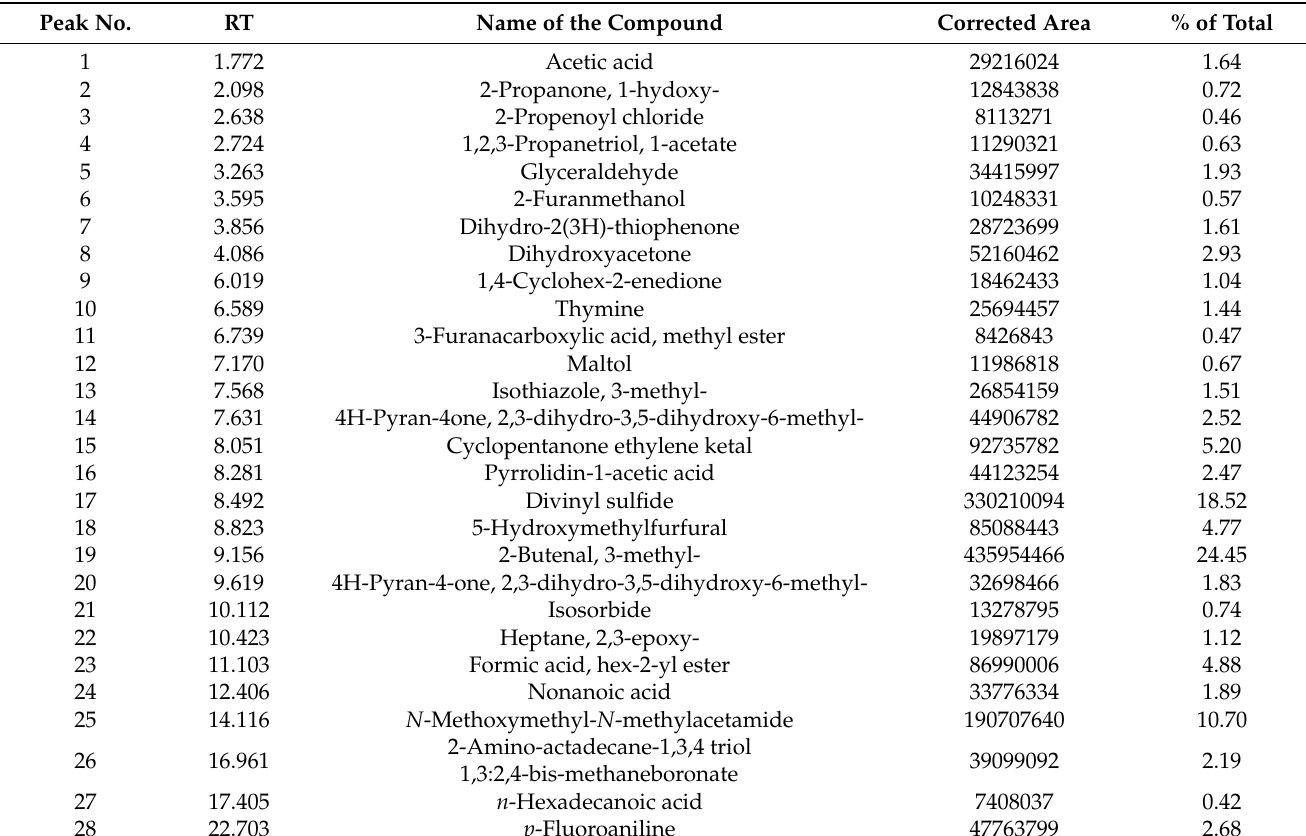
Table 1. Phytochemical analysis of ethanol extract of